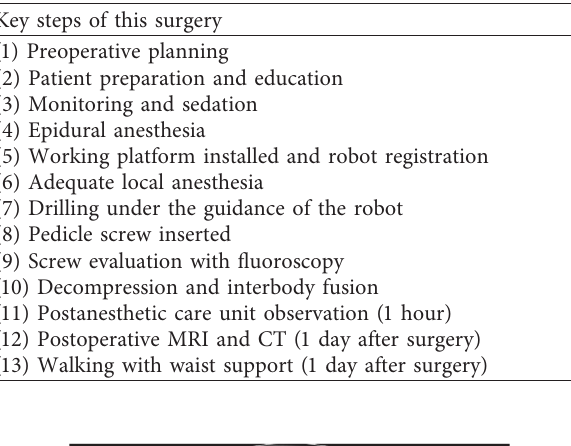
Table 1: The protocol of robot-assisted percutaneous endoscopic lumbar interbody fusion under regional anesthesia.